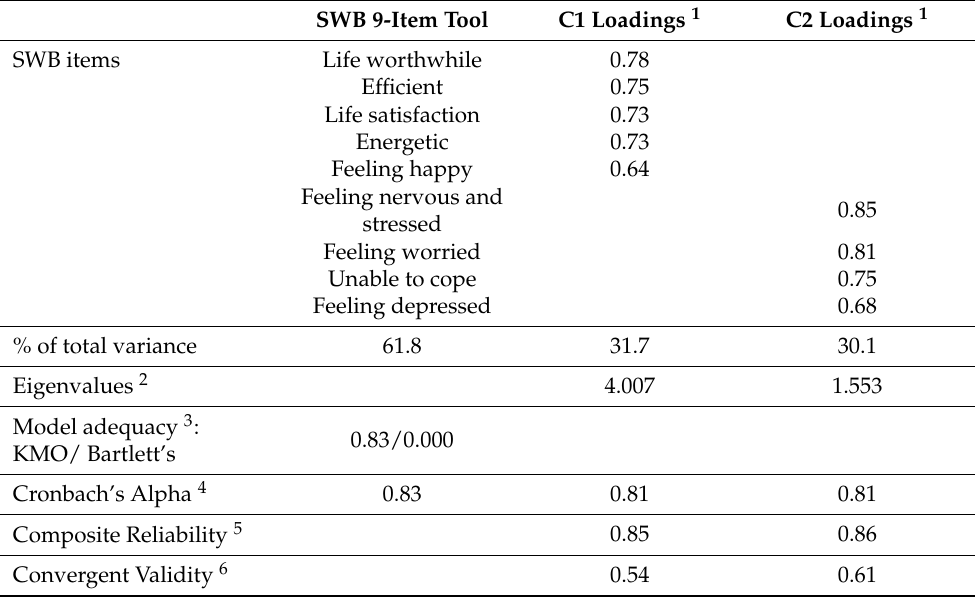
Table 4. Results of the exploratory factorial analysis, internal consistency, and convergent validity of the pooled SWB 9-item tool.